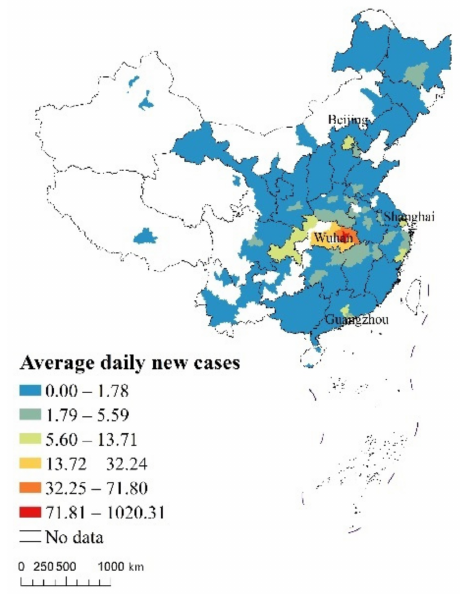
Figure 1. The maps of average daily new COVID-19